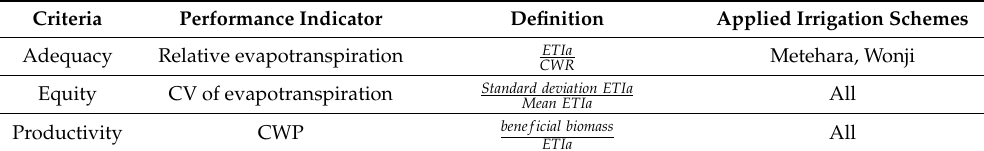
Table 3. Irrigation performance indicators and their properties